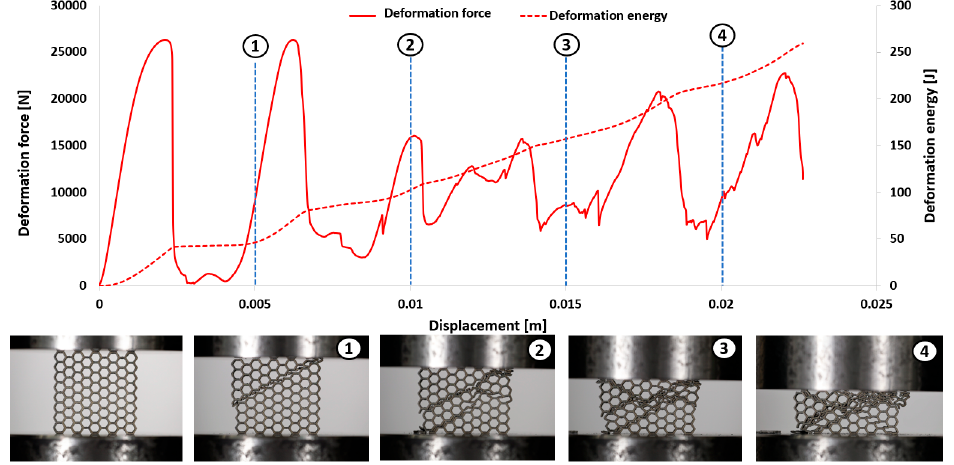
Figure 13. Deformation process of specimen No. 2 manufactured additively with LENS (1–4 stages of deformation during static compression